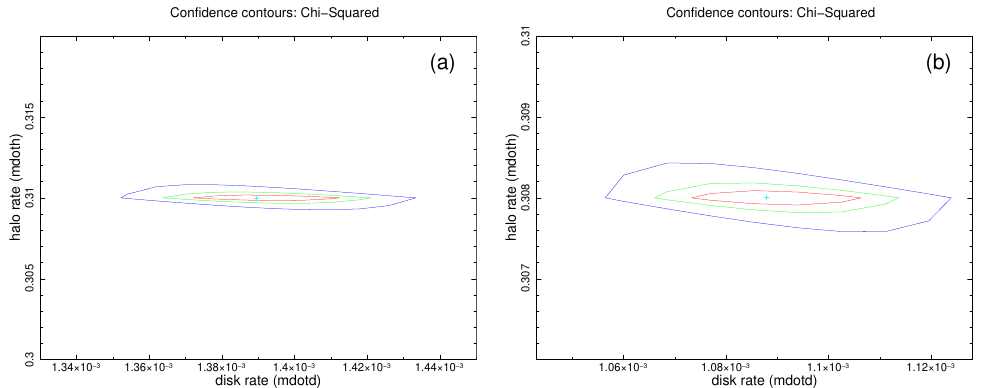
Figure 9. Confidence contours of disk rate ( ˙ m d ) vs. halo rate ( ˙ m h ) for two datasets: ( a ) Swift/XRT Obs. ID = 00011107045 (MJD = 58,685) in the left panel and ( b ) the combined data of NICER Obs. ID = 2200530187 with MAXI/GSC (MJD = 58,693) in the right